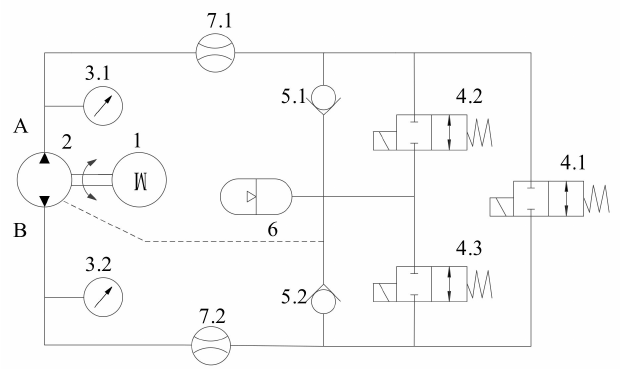
Figure 13. Schematic of the dead-zone compression test. 1—servo motor; 2—fixed-displacement pump; 3.1/3.2—pressure gage; 4.1/4.2/4.3—magnetic exchange valve; 5.1/5.2—one-way valve; 6—accumulator; 7.1/7.2—flow sensor.